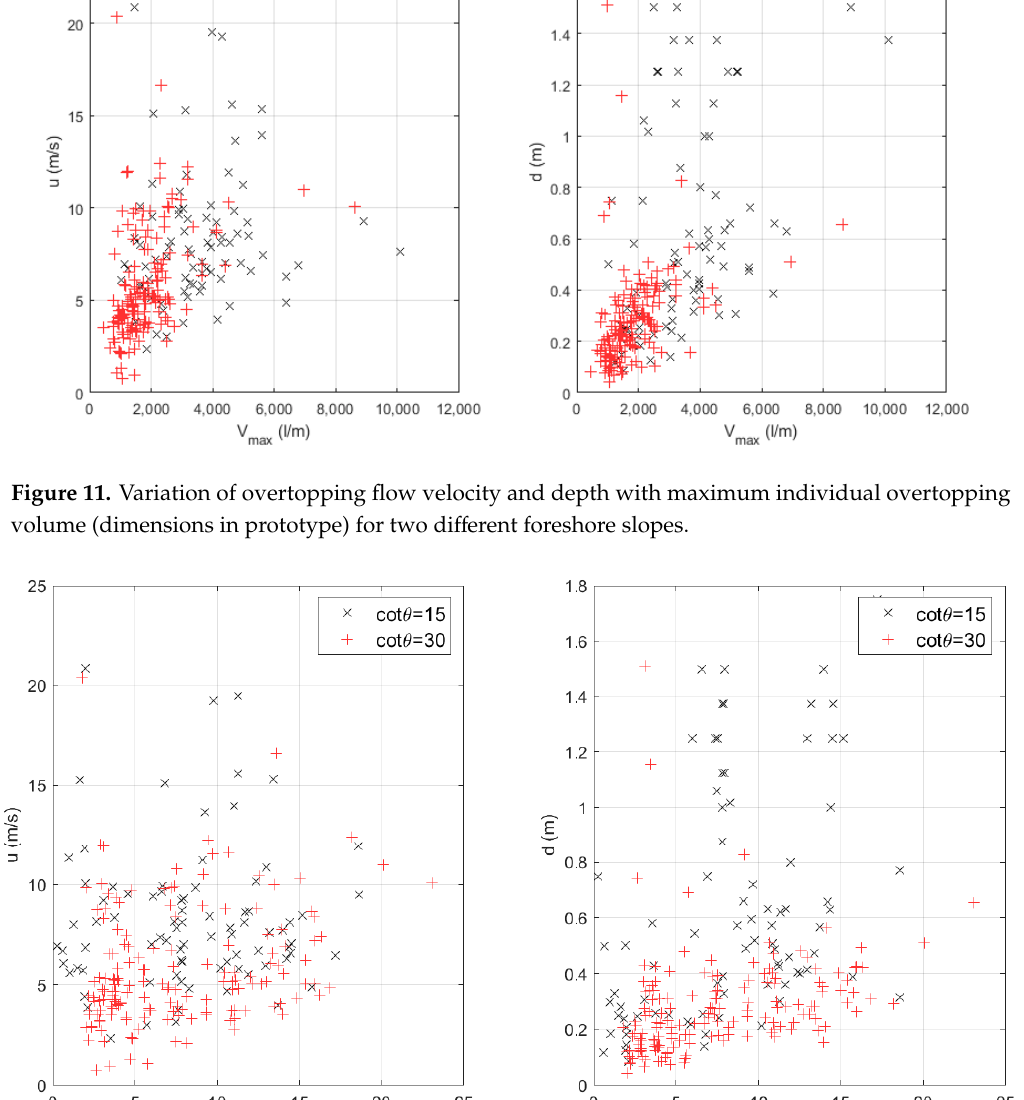
Figure 12. Variation of overtopping layer velocity and depth with average overtopping discharge ff erent foreshore (dimensions in prototype) for two different foreshore slopes. (dimensions in prototype) for two di